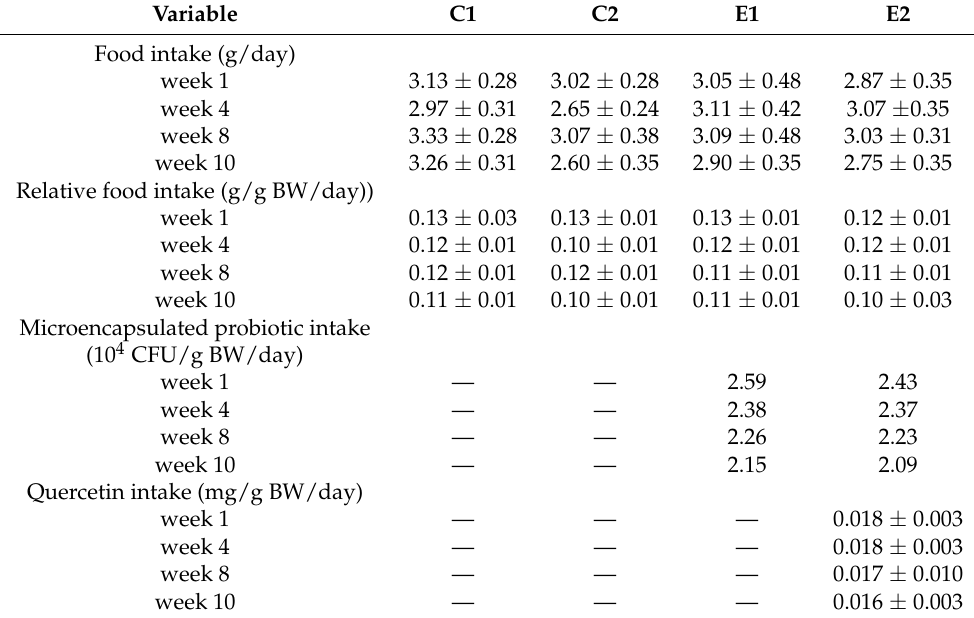
Table 1. Body weight (BW), food intake, relative food intake, microencapsulated probiotic, and quercetin intake in the four experimental dietary groups measured at different timepoints. Variable C1 C2 E1 Food intake